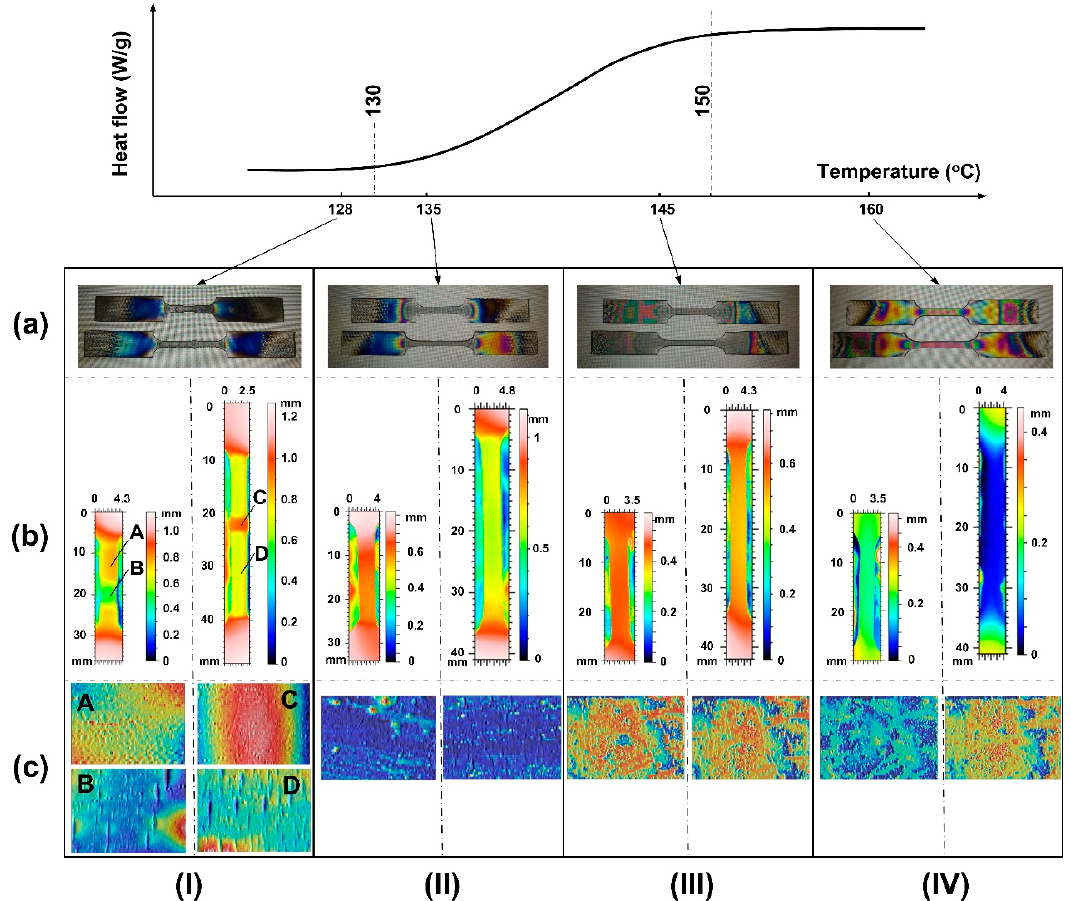
Figure 11. Summary of samples programmed to 30% and 100% strains at four temperatures of 128 °C ( I ); 135 °C ( II ); 145 °C ( III ) and 160 °C ( IV ). Top-subfigure: illustration of DSC curve. ( a ) Image of photo-elastic effect (top sample: 30% strain; bottom sample: 100% strain); ( b ) macro-scale 3D scanning result of sample surface (by Taylor Scanner); ( c ) micro-scale 3D scanning of zoom-in surface (area: 140 × 100 μ m) (by PL μ Confocal Imaging Profiler).